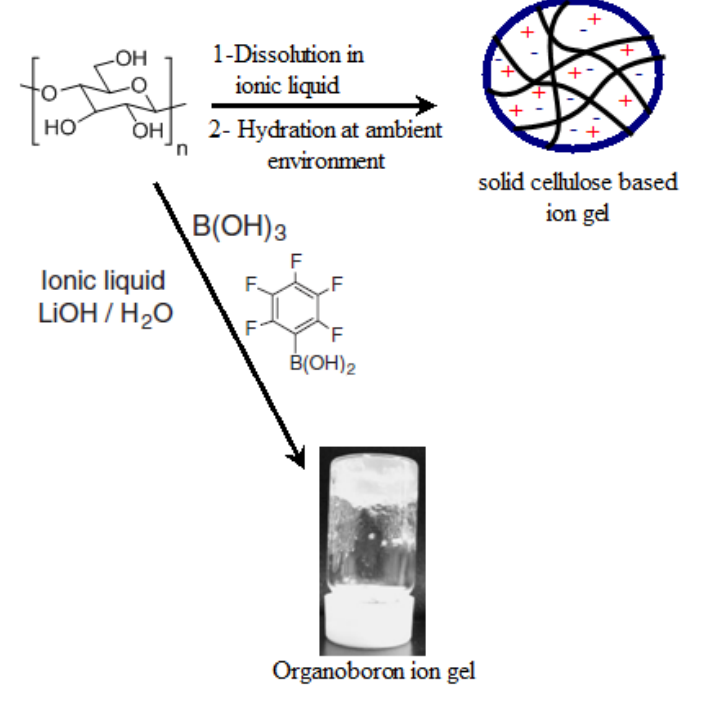
Figure 5. Two different approaches to produce cellulose containing ion